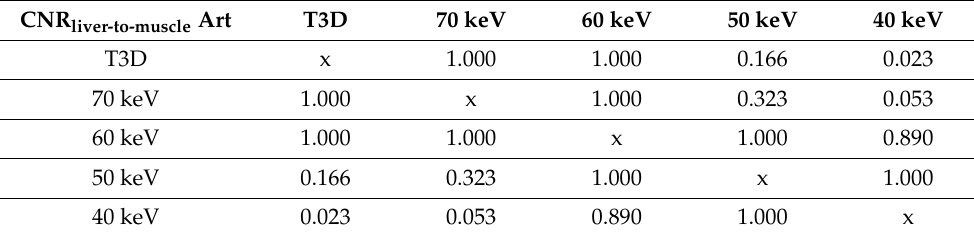
Table 9. Comparison of arterial CNR liver-to-muscle between T3D and low keV